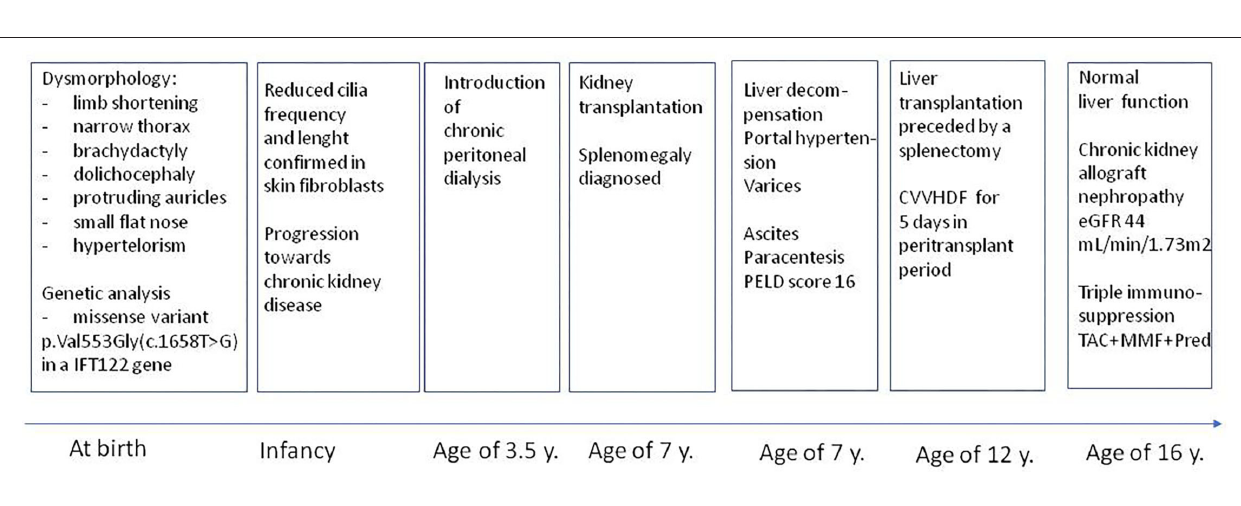
FIGURE 3 | Clinical course during 16-year